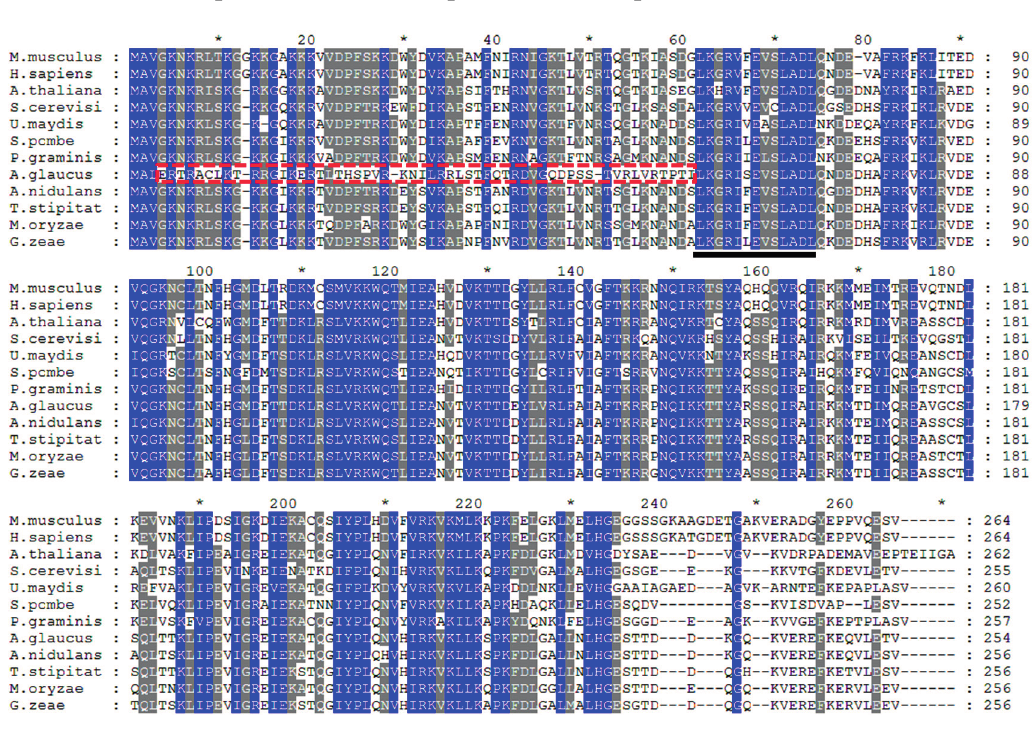
Figure 3. Multiple alignment of AgRPS3aE with RPS3aE from other species in GenBank. Identical residues are shown in blue, and similar residues are shown in grey. The RPS3aE signature motif is underlined. The amino acid sequence indicated by the dotted line is unique to AgRPS3aE. * represents the amino acid number increased by twenty from the 10th amino